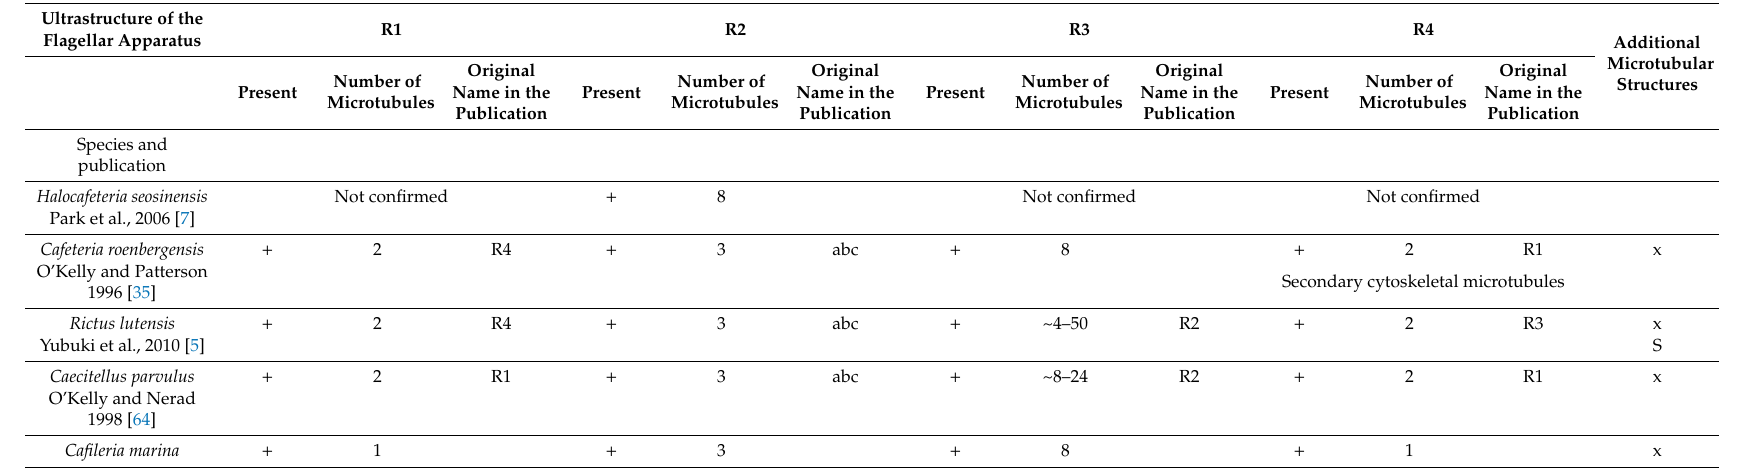
Table 1. Comparison of the Cafileria marina flagellar apparatus with closely related bicosoecids. The terminology was adopted from [30]. ‘S’ is the additional microtubular structure unique to R. lutensis , similar to ‘x’, which consists of a single microtubule, but lays on top of the R3 root and copies its shape. Ultrastructure of the Flagellar Apparatus